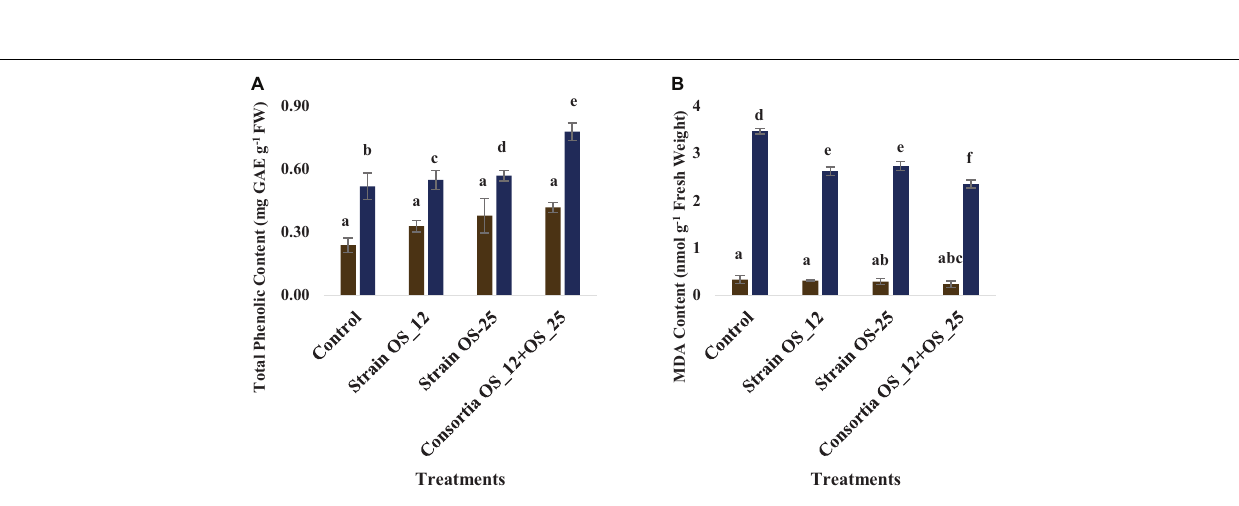
FIGURE 11 | Effect of pathogen and endophytic bacterial inoculation on activities of different defense related antioxidative enzymes (A) total phenolic content, (B) malondialdehyde (MDA) content. Columns represent Mean values ± Standard deviation ( n = 3). Blue bar, normal conditions; yellow bar, pathogen challenged conditions. Different letters indicate statistical difference between treatments (Turkey’s post test P <